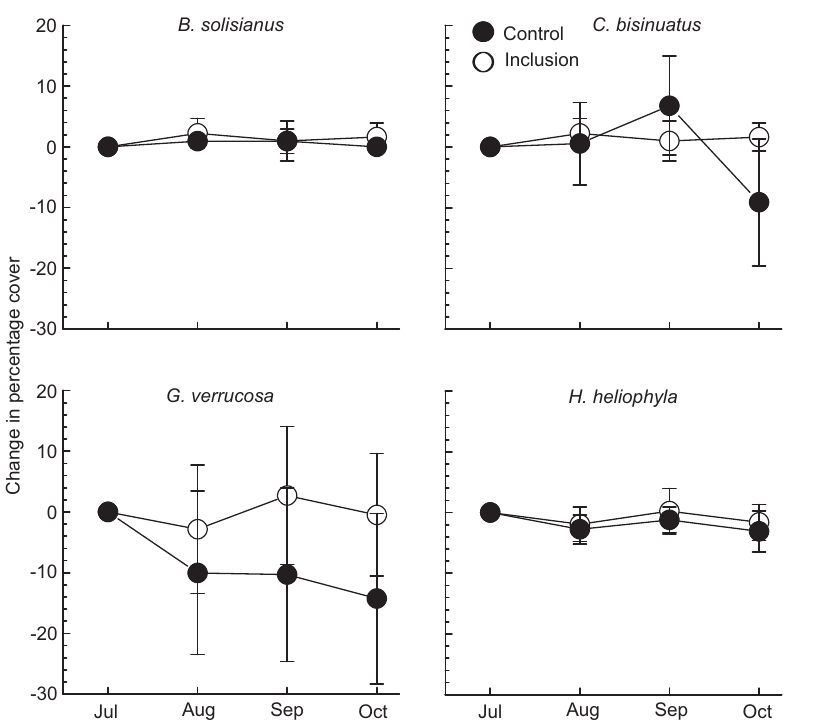
Figure 3. Change in abundance (mean ± 95% confidence intervals) of four selected sessile species on permanent quadrats (100 cm 2 ) between subsequent months during an inclusion experiment of A. stellifera in Penha, Santa